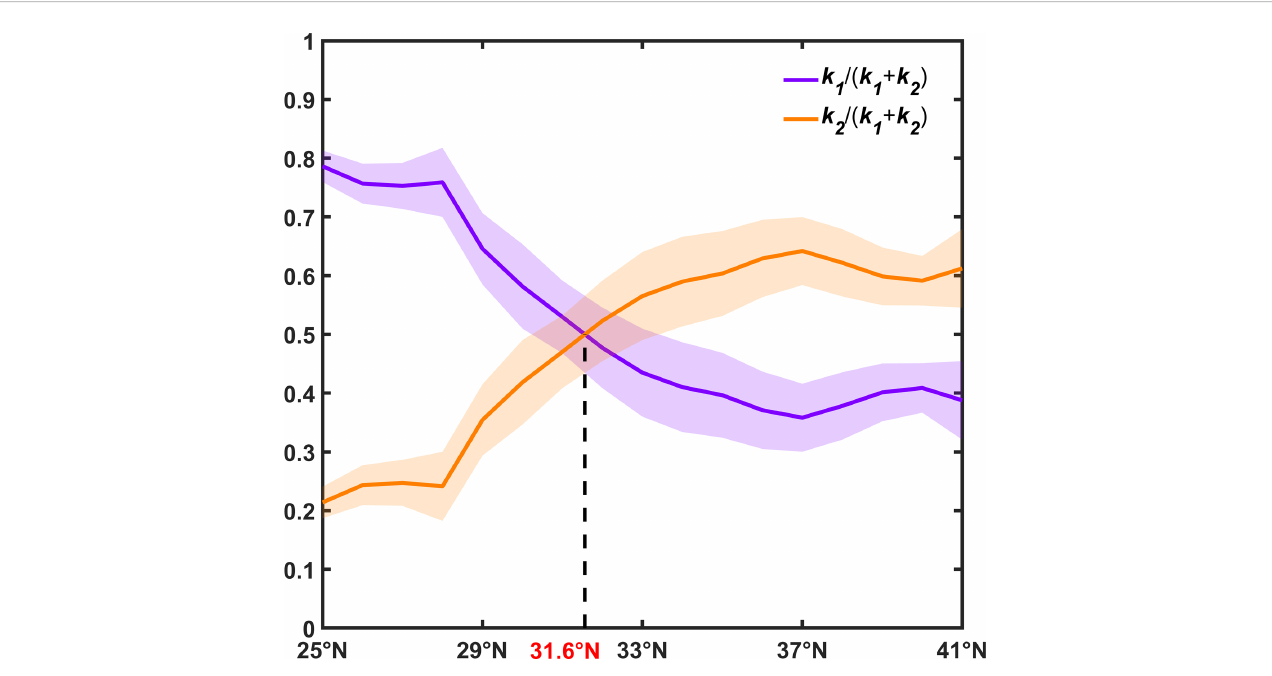
FIGURE 7 Relative values of coef fi cients as a function of latitudes. The bold lines indicate the relative values of coef fi cients derived from multi-year averaged seasonal cycles at different latitudes. The shading areas denote the standard deviations of coef fi cients calculated from the seasonal cycle of each year at different latitudes.